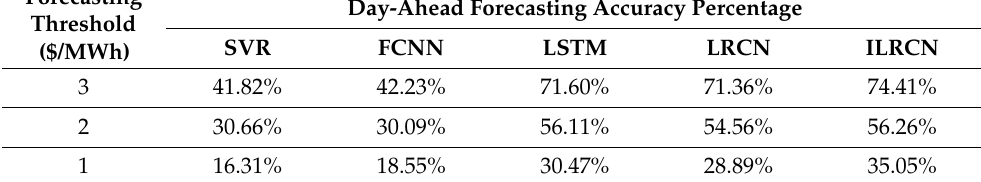
Table 3. Accuracy percentage comparison between FCNN model, LSTM model, LRCN model, and the proposed ILRCN model for day-ahead